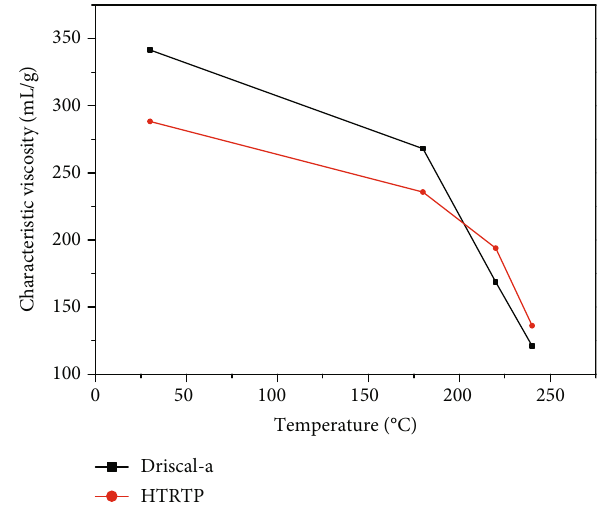
Figure 4: Viscosity-temperature curves of HTRTP and